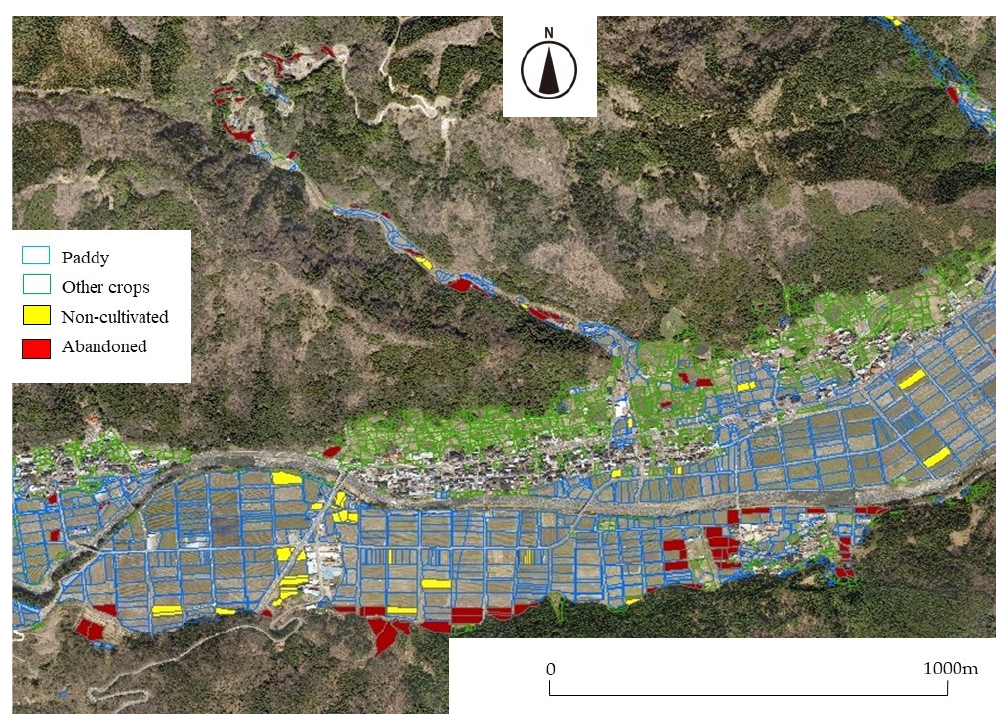
Figure 2. GIS data of farmland abandonment in Yabu City.